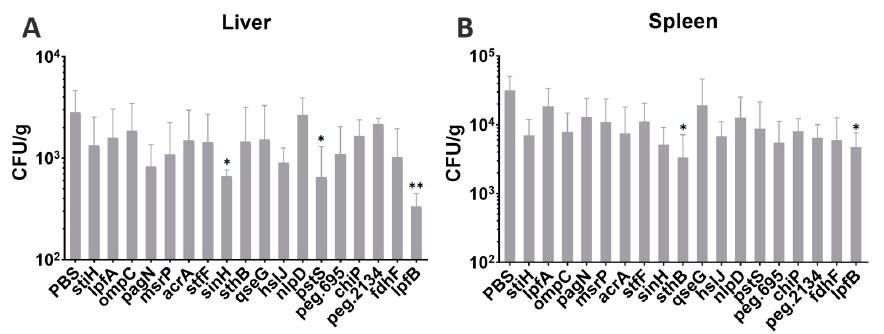
Figure 5. Bacterial loads in the spleen and liver were determined on day 7 after infection with S. Pullorum R51. Statistical analysis compared to NC group. p < 0.05(*), p < 0.01(**). ( A ) Liver, ( B ) Spleen.